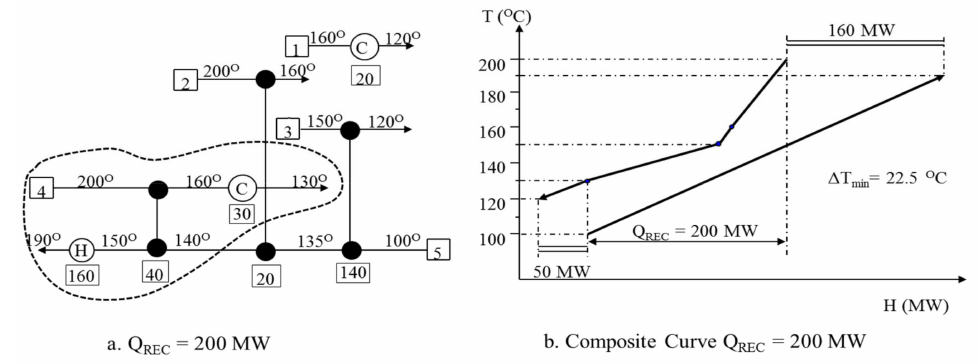
Figure 1. An existing network.